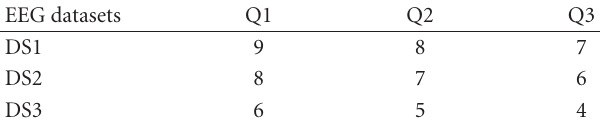
Table 4: Values of CR obtained at